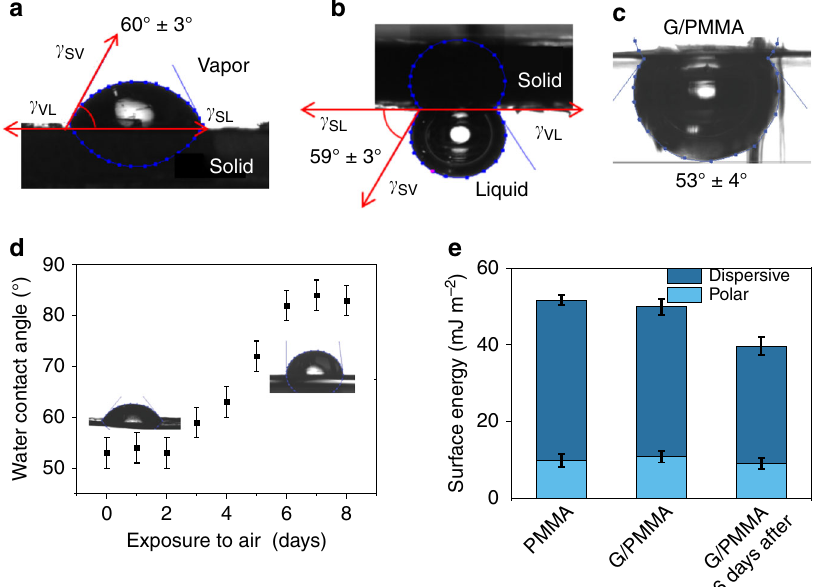
Fig. 1 Sessile drop and captive bubble measurements of graphite and supported graphene. a Sessile drop of water on freshly exfoliated highly oriented pyrolytic graphite (HOPG) in air, where γ VL , γ SV , and γ SL are the liquid − vapor, solid − vapor, and thesolid − liquid interfacial tensions, respectively. The measured contact angle is 60° ± 3°. The measurement was reproduced on ten samples and the error bar represents the standard deviation. b Captive bubble con fi guration on freshly exfoliated HOPG in water. The measured contact angle is 59° ± 3°. The measurement was reproduced on ten samples and the error bar represents the standard deviation. c Captive bubble measurement of water contact angle on graphene supported by a poly(methyl methacrylate) (PMMA) layer. The measurement was reproduced on ten samples and the error bar represents the standard deviation. d Sessile drop contact angle measurement of graphene supported by a PMMA layer constantly exposed to air as a function of air exposure time. The measurement was reproduced on three samples and the error bar represents the standard deviation. e Surface energies and polar and dispersive components of the surface energy for PMMA, graphene supported by PMMA, and graphene supported by PMMA which was exposed to air for six days. The measurement was reproduced on three samples and the error bar represents the standard